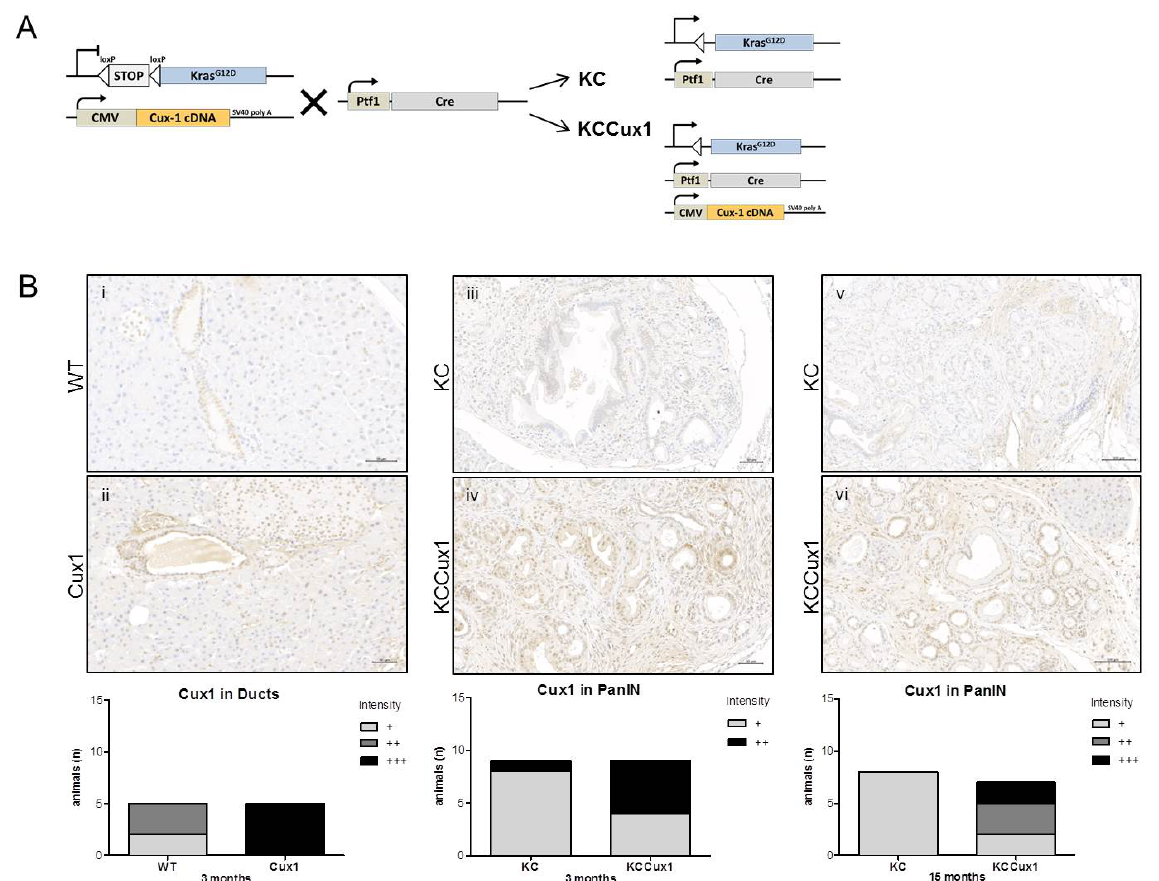
Figure 1. Generation and validation of KCCux1 mice. ( A ) Breeding scheme for the generation of KrasLSL-G12D/+; Ptf1aCre/+; CMV-Cux1+/ − mice (p200 CUX1). KrasLSL-G12D/+; CMV-Cux1+/ − mice were mated with Ptf1aCre/+ mice to generate Kras-activated KrasLSL-G12D/+; Ptf1aCre/+ and KrasLSL-G12D/+; Ptf1aCre/+; CMV-Cux1+/ − animals. ( B ) Representative immunohistochemistry (top) of CUX1 in pancreatic section obtained from 3-month-old WT ( i ), Cux1 ( ii ), KC ( iii ) and KCCux1 ( iv ), as well as 15-month-old KC ( v ) and KCCux1 ( vi ) animals. Original magnification: 200×. Scale bar, 50 µm. Quantification (below) of Cux1 intensity in pancreatic ducts of 3-month-old WT ( n = 5) and Cux1 ( n = 5) mice and in mPanIN areas of 3-and 15-month-old KC ( n = 8) and KCCux1 ( n = 7) mice. Immunohistochemistry intensity score: + weak, ++ moderate, +++ strong.